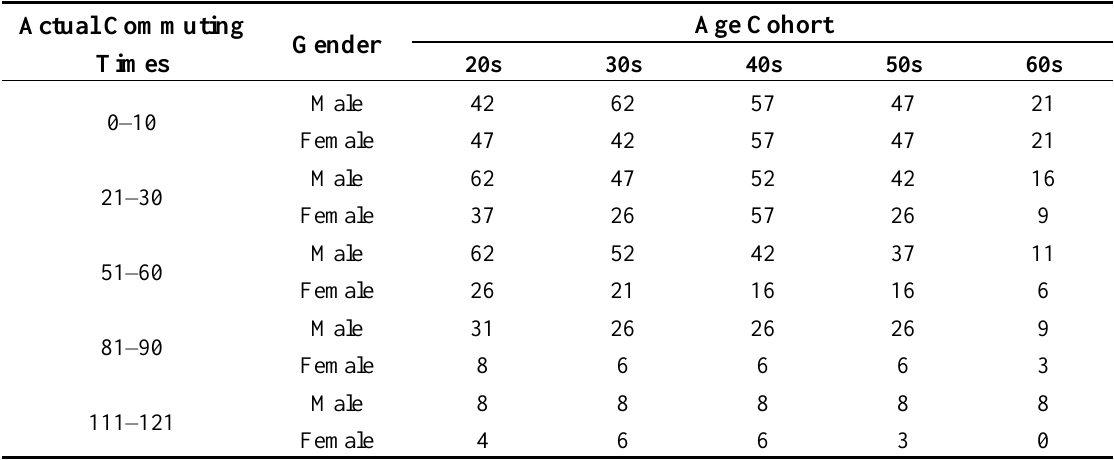
Table 1. Respondents attributes of questionnaire survey on commuting